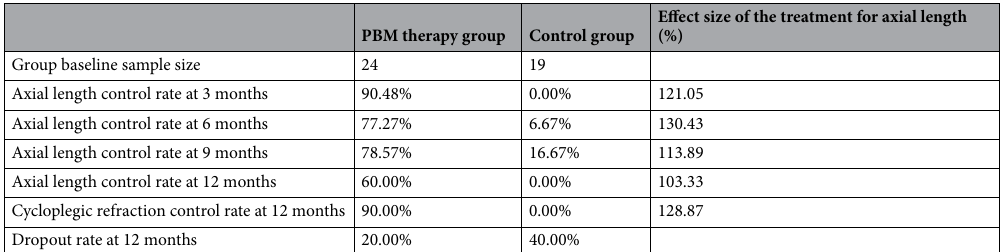
Table 3. Myopia control rates in absolute numbers (≤ baseline) and follow-up dropout rates. PBM Therapy Group, Photobiomodulation Therapy Group; Control Group, single-vision spectacles group. The effect sizes of the treatment between the two groups were calculated with the following formula: mean changes of PBM group − mean change of control group mean change of control group